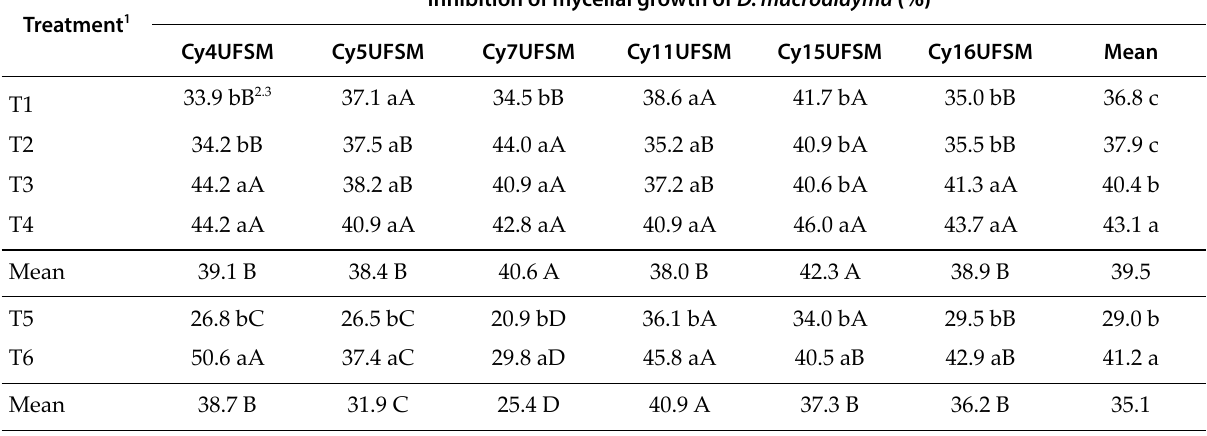
Table 4. Mean inhibition of mycelial growth (%) of isolates of Dactylonectria macrodidyma in in vitro paired culture with isolates of Trichoderma spp. and Bacillus subtilis